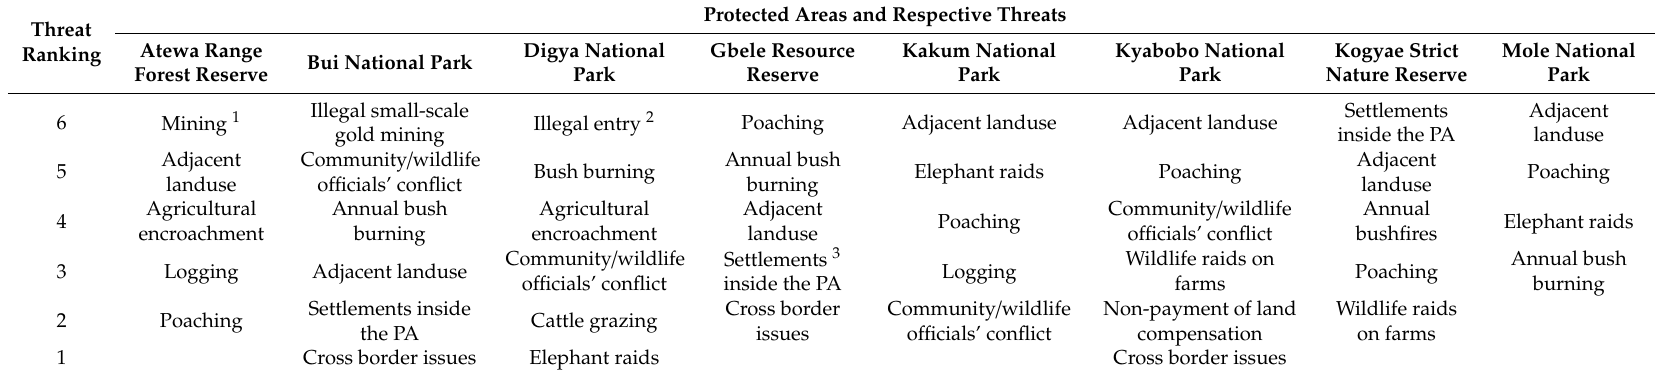
Table 3. Ranking of Proximate Threats to Protected